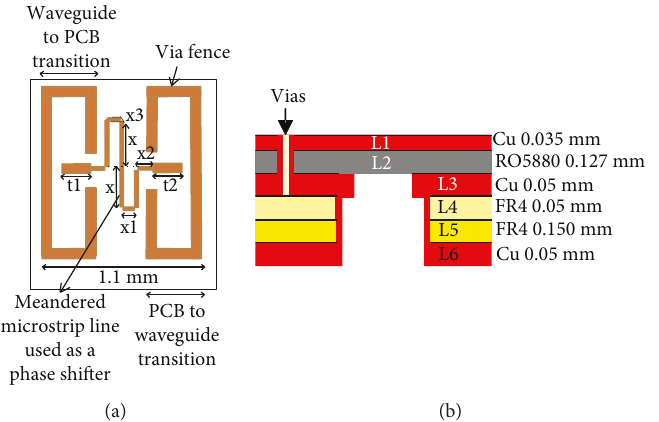
Figure 8: (a) The PCB structure consisting of the waveguide-to-PCB transition, phase shifter, and PCB-to-waveguide transition. (b) Layer stack-up for manufacturing the multilayer PCB.